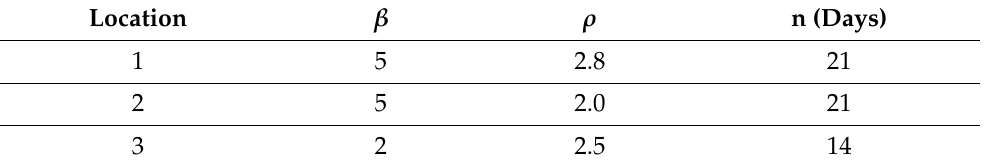
Table 3. Overview of chosen β and resulting parameters for each location.